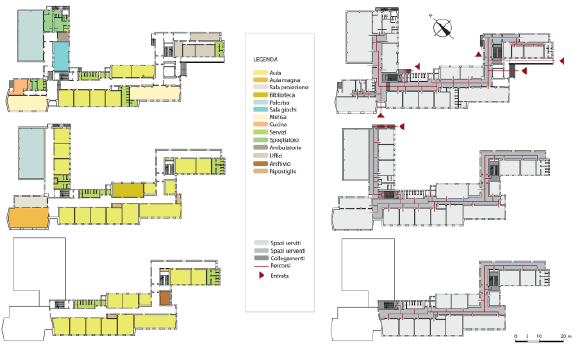
Figure 3. G. Pascoli school: distribution of